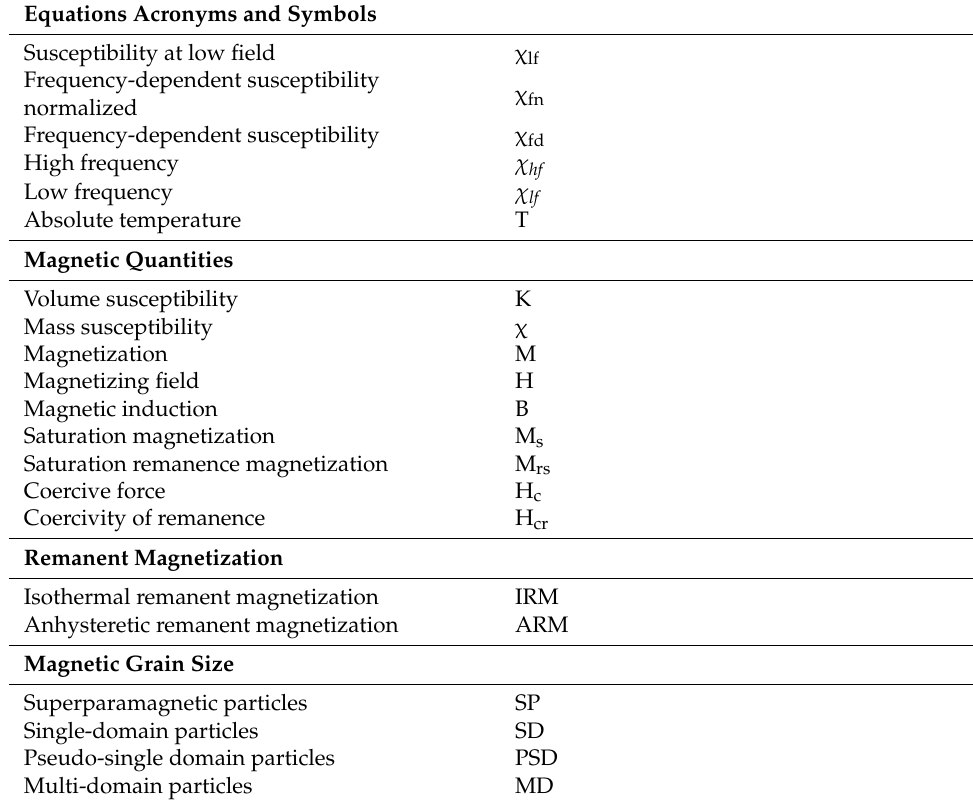
Table 1. Acronyms and symbols used in the manuscript. Equations Acronyms and